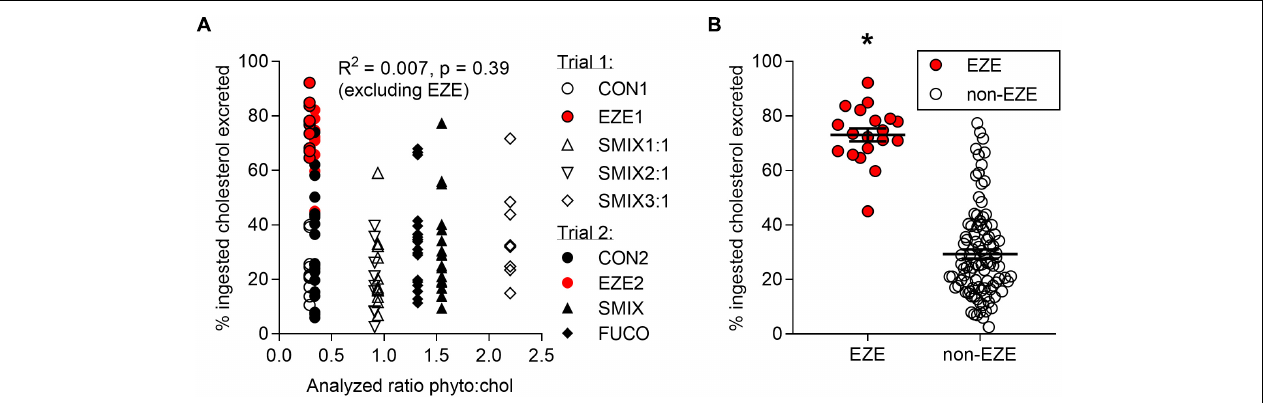
FIGURE 1 | Excreted [4- 14 C] cholesterol (as percent of ingested [4- 14 C] cholesterol) of fish from both trials. (A) Individual values plotted against their respective analyzed dietary ratios of phytosterols:cholesterol (no effect of dietary phytosterol:cholesterol ratio on the excretion of exogenous cholesterol). CON, control diet without added phytosterols; SMIX, diet with phytosterol added as a sterol extract from soybean/rapeseed; FUCO, diet with phytosterol added as pure fucosterol. (B) Individual values as well as mean ± SEM plotted as either not exposed to ezetimibe in the water (non-EZE, n = 96) or exposed to ezetimibe (EZE, n = 20). The fish exposed to ezetimibe had a significantly higher excretion of cholesterol, as indicated by ∗ ( p < 0.001, nested ANOVA).